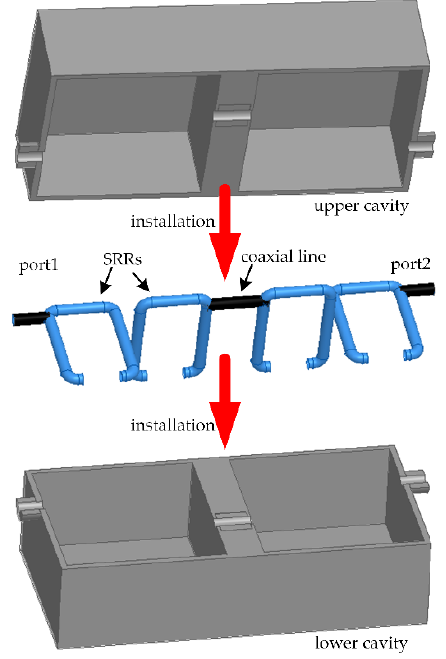
Figure 6. Installation and assembly of the two-cavity filter.